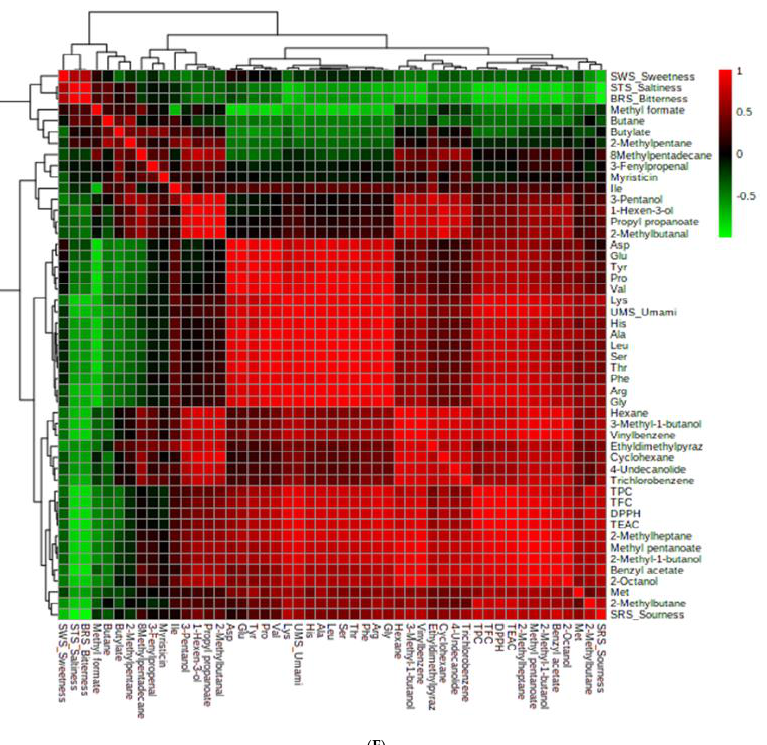
Figure 4. Correlation analysis between aroma metabolites and characteristics of hot and cold bever- ages. The pattern of the top 25 compounds correlated with the sourness ( A ), saltiness ( B ), umami ( C ), sweetness ( D ), and bitterness ( E ), and the Pearson correlation heatmap ( F ). Ala, alanine; Arg, arginine; Asp, aspartic acid; Glu, glutamic acid; Gly, glycine; His, histidine; Ile, isoleucine; Leu, leu- cine; Lys, lysine; Met, methionine; Phe, phenylalanine; Pro, proline; Ser, serine; Thr, threonine; Tys, tyrosine; Val, valine. 3.6. Clustering Analysis and Principal Component Analysis of Metabolites in Hot and Cold Bev- erages In order to comprehensively understand the flavor metabolites in different infusion loads and types of beverages, multivariate and chemometric analyses were applied to il- lustrate the clustering heatmap (Figure 5A) and the principal component analysis (PCA) (Figure 5B). The clustering heatmap provided the component of each feature in different samples by arranging stronger color intensities (from light green to red) in order to in- crease the level of components. As shown in Figure 5B, the PCA biplot differentiated the